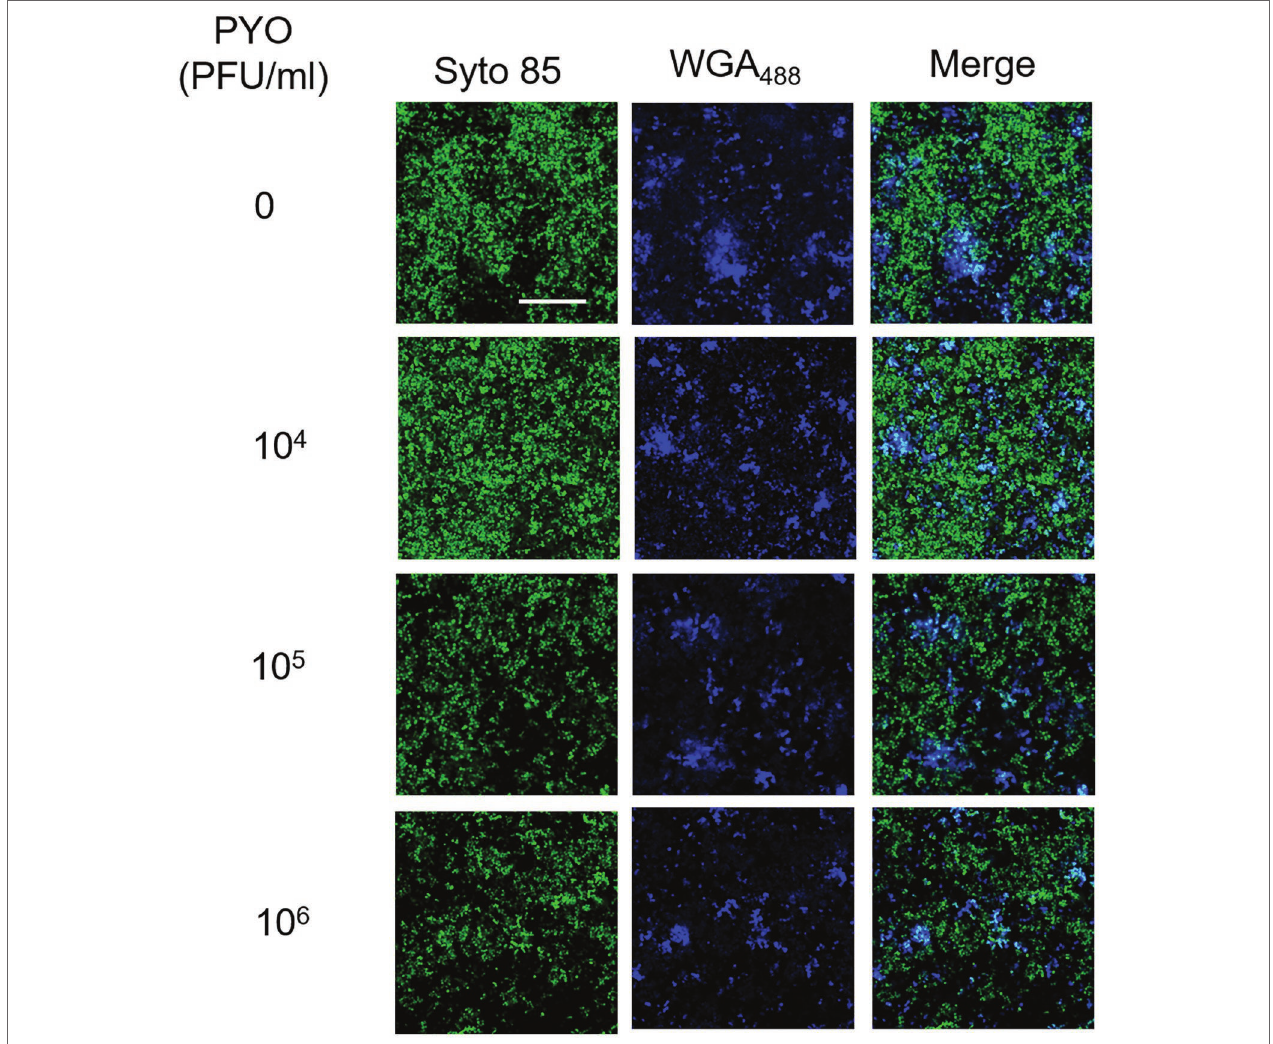
FIGURE 4 | CLSM images of MRSA ATCC 43300 biofilm treated with/without PYO. MRSA biofilm (24 h old) was exposed for 24 h to different PYO titers (ranging from 0 to 10 6 PFU/ml) and then stained with WGA488 (488/500–600 nm – blue) for exopolysaccharides and SYTO™85 (561/600–700 nm – green) for bacterial cells. Scale bar: 25 μ